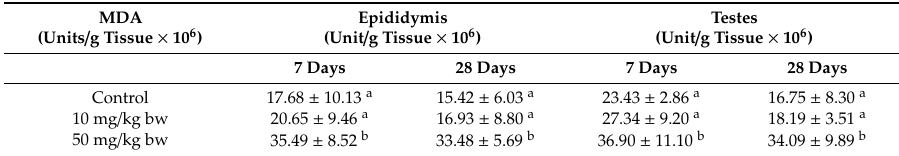
Table 9. Effect of sub-dermal administration of Ag-NP on malondialdehyde (MDA) level in testes and epididymis of experimental rats.